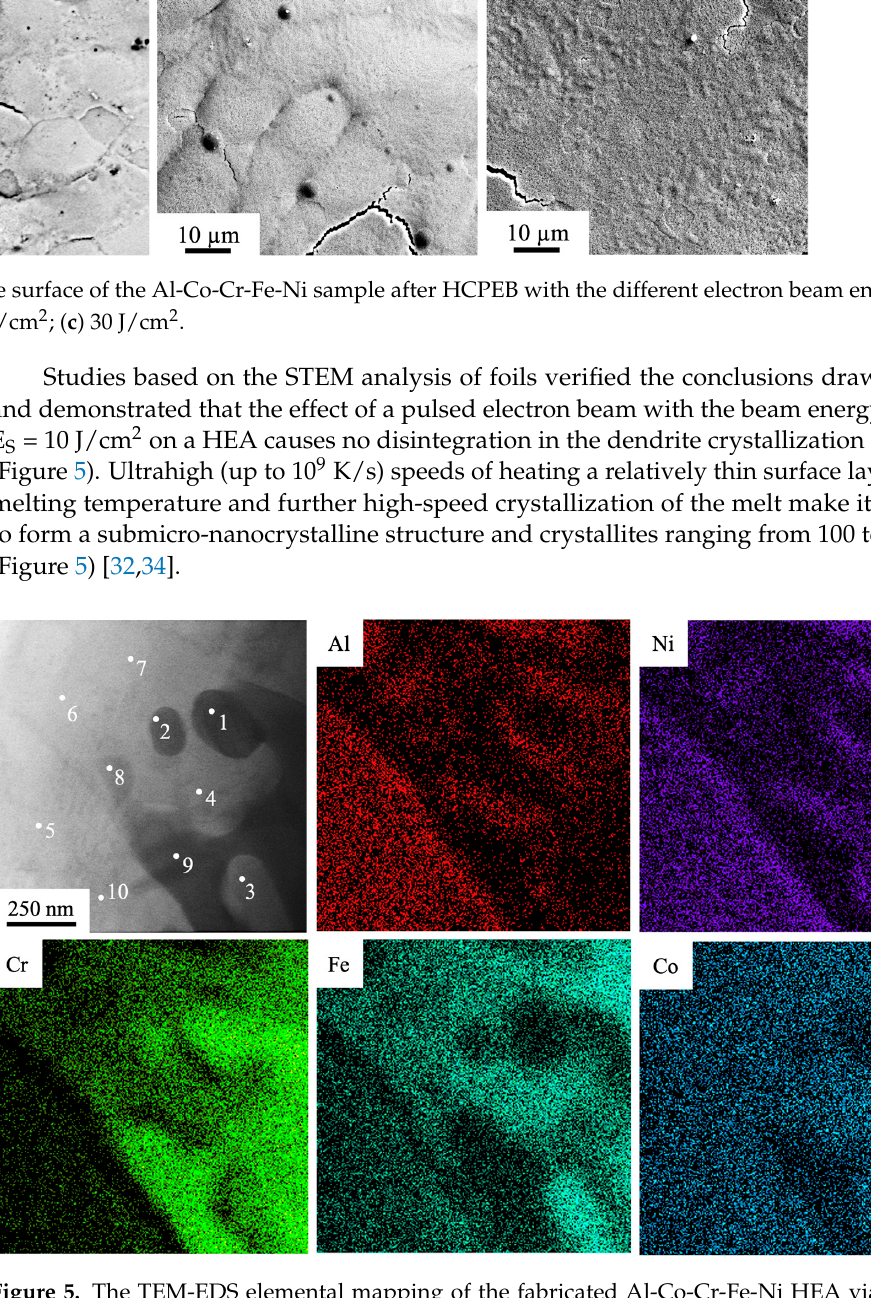
Figure 5. The TEM-EDS elemental mapping of the fabricated Al-Co-Cr-Fe-Ni HEA via wire-arc additive manufacturing and irradiated by HCPEB (10 J/cm 2 , 50 µs, 3 pulses, 0.3 s –1 ). The numbers indicate areas where EDS analysis was carried out.